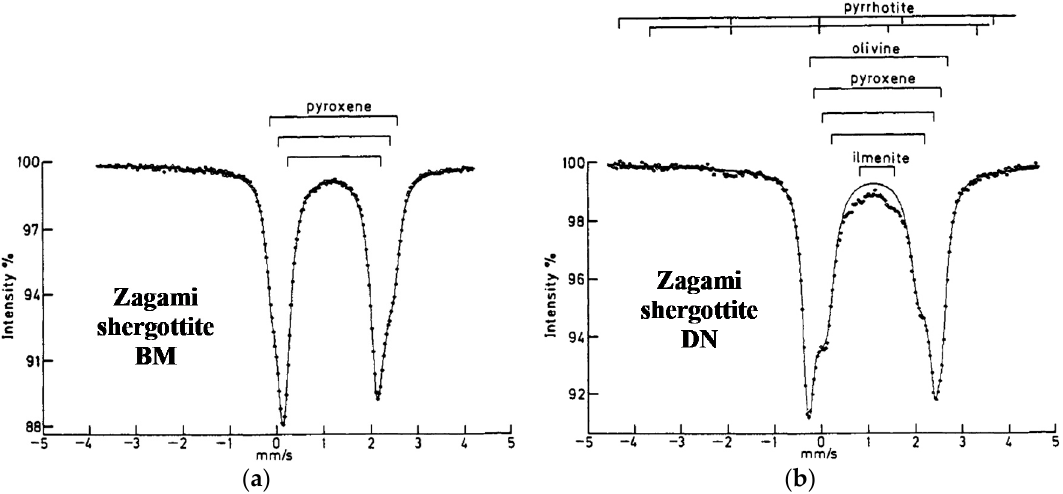
Figure 10. Room temperature Mössbauer spectra of Zagami shergottite: sample BM ( a ) and sample DN ( b ). Indicated components are the results of the fits. Adapted from [27].